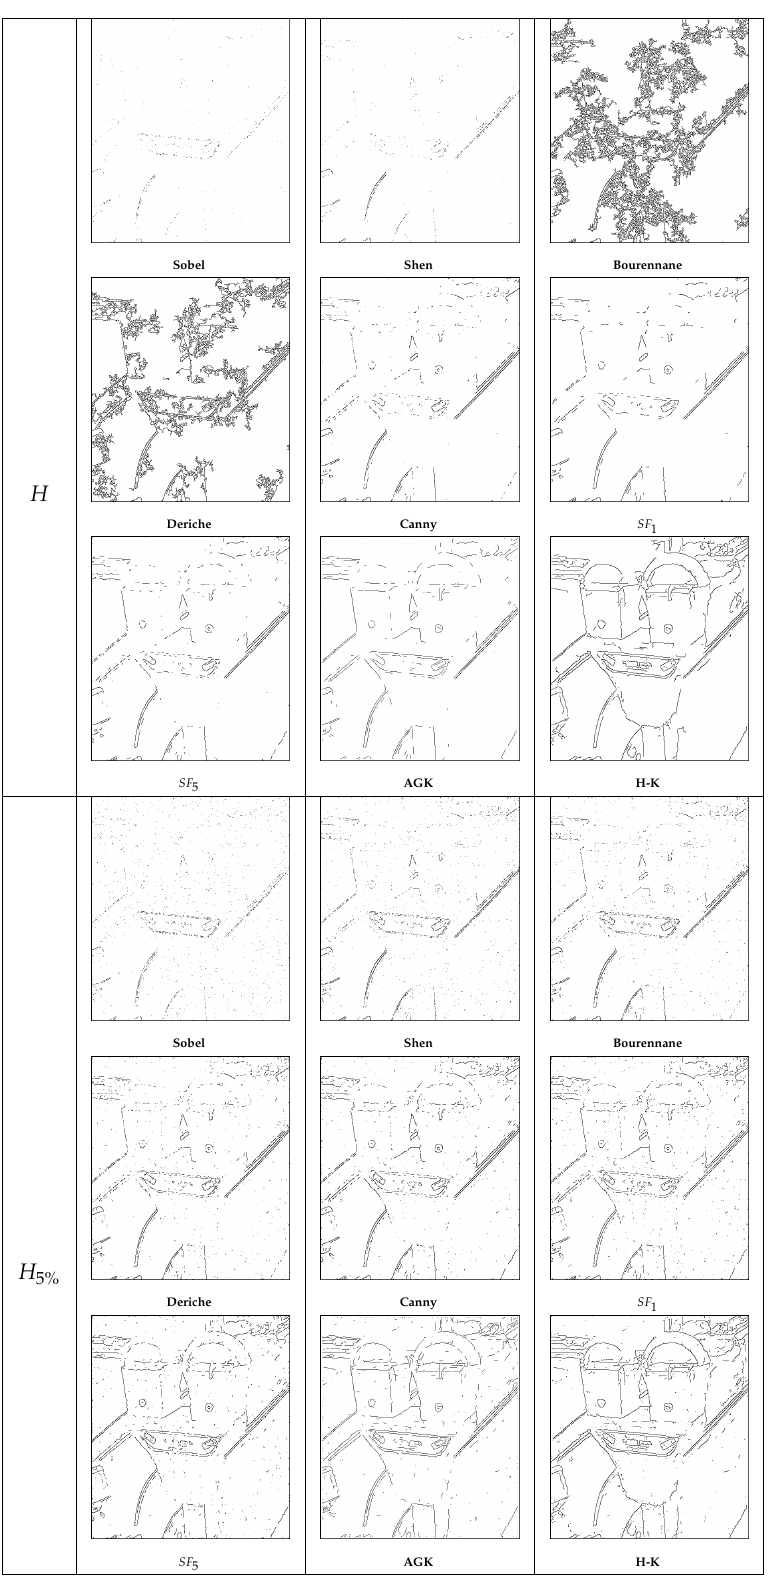
Figure 40. Ideal segmentations for several edge detectors on image parkingmeter, PSNR = 14